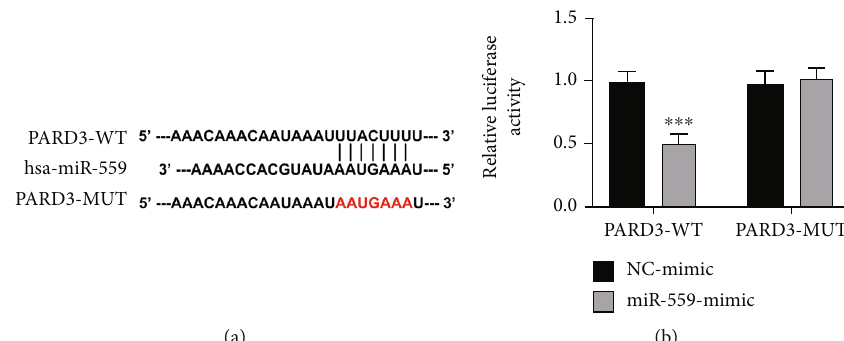
Figure 4: PARD3 was a target gene of miR-559. (a) Target prediction between PARD3 and miR-559. (b) Luciferase reporter constructs containing wild-type or mutated miR-559 paring sites of PARD3 were cotransfected with the miR-559 mimic or mimic NC into Huh-7 cells. The values were obtained from three independent experiments and shown as mean ± SD . ∗∗∗ p < 0 : 001 , compared with mimic